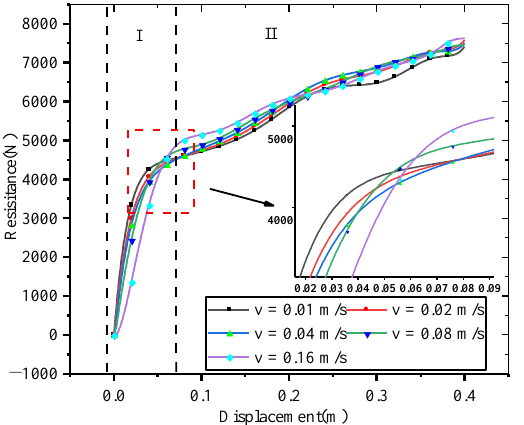
Figure 15. Variation curves of resistance with displacement at different velocities.